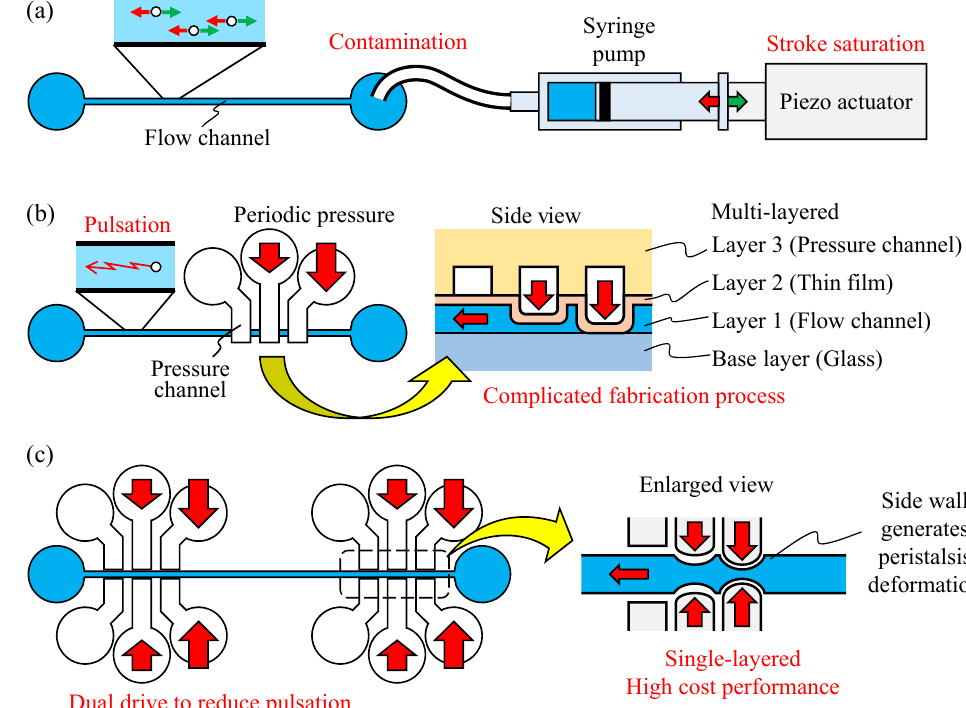
Figure 1. Particle position control systems, where ( a – c ) show a traditional system actuated by an external syringe pump, a multi-layered internal micropump, and a single-layer, dually driven micropump,